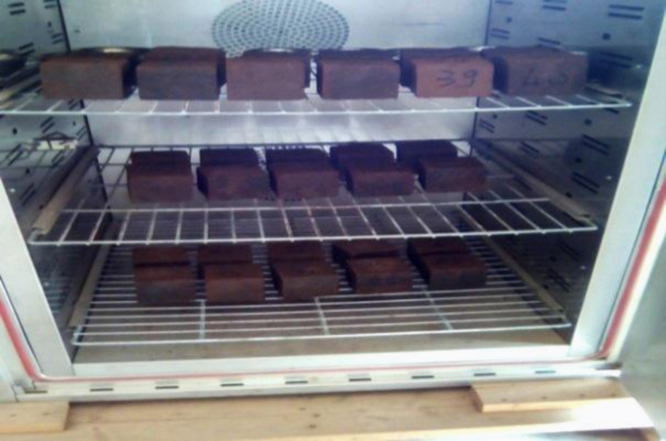
Block in an oven.